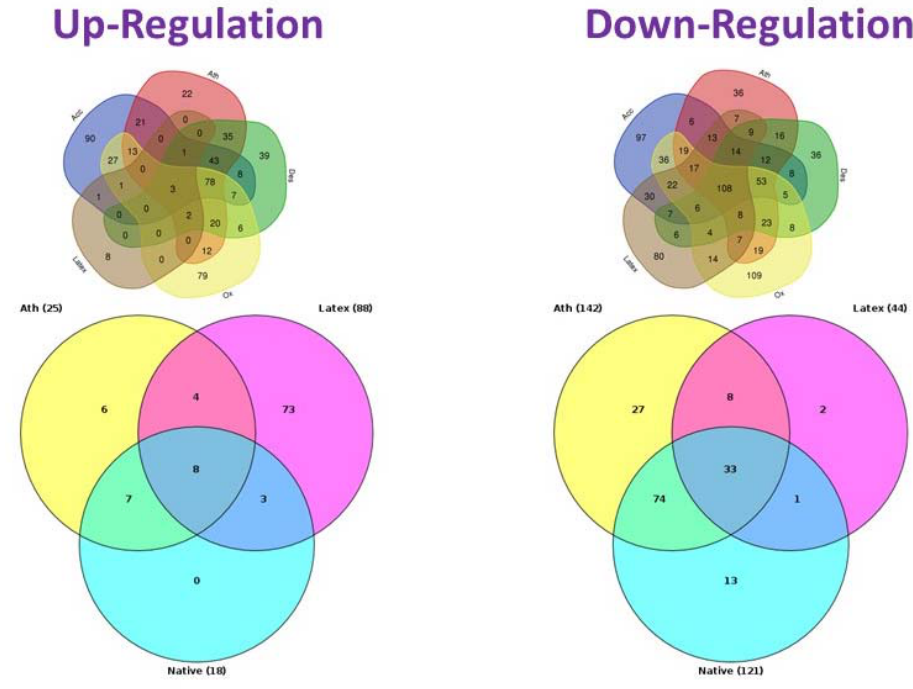
Figure 2. Venn diagrams of signaling pathways. The upper panel shows all the tested samples (Ath, atherogenic LDL; Acc, acetylated LDL; Des, desialyated LDL; Ox, oxidized LDL; Latex, latex beads). The bottom panel show only signaling pathways that change when interacting with native LDL (control), as well as latex beads and multiple modified LDL isolated from the blood of atherosclerotic patients (reported: